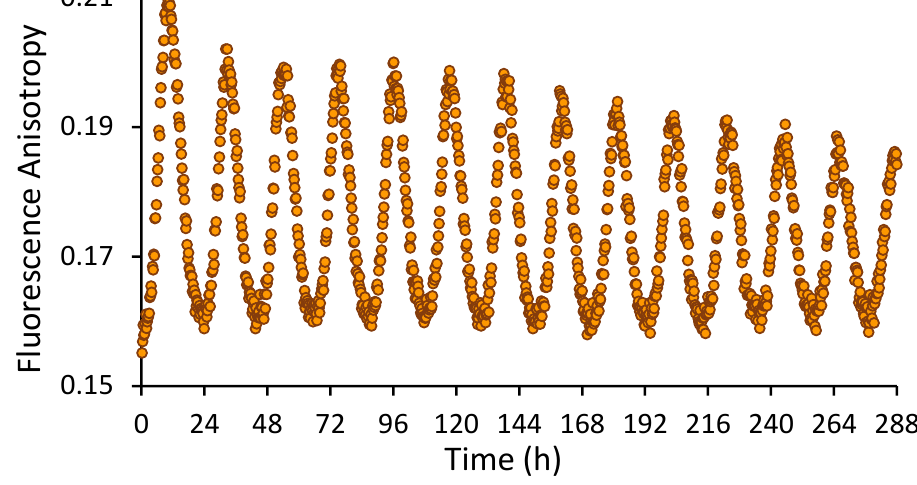
Figure 5. Fluorescence anisotropy of 0.05 µM KaiB-FLAG-K25C-6IAF in a reaction also containing unlabeled KaiA, KaiB-FLAG [20], and FLAG-KaiC at 1.2 µM, 3.45 µM, and 3.5 µM, respectively. Data points were collected every 15 min for 12 days.